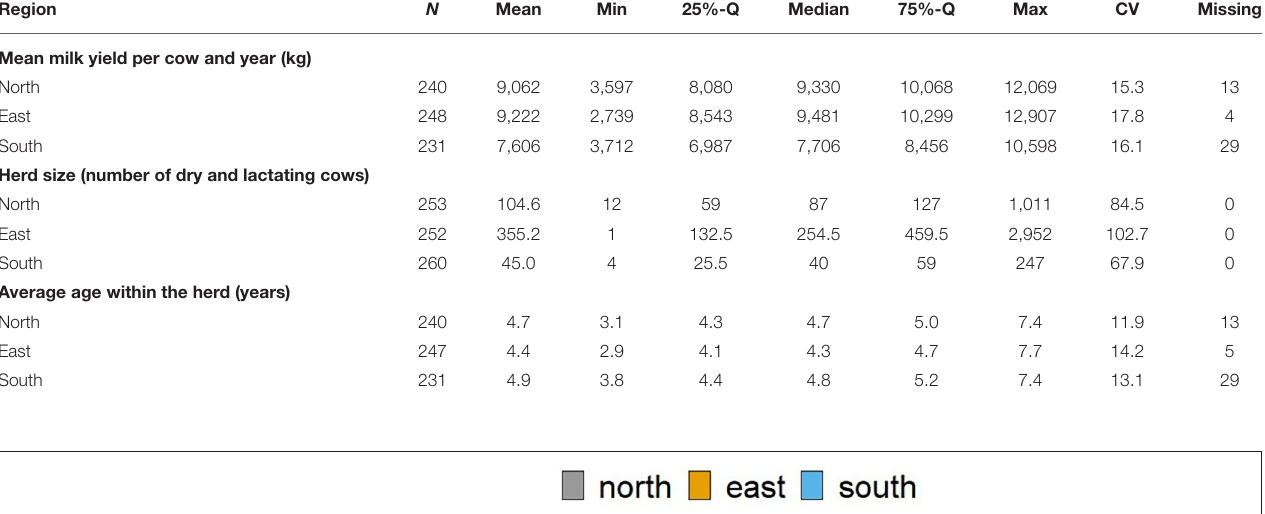
TABLE 1 | Characteristics of farms. Region Missing